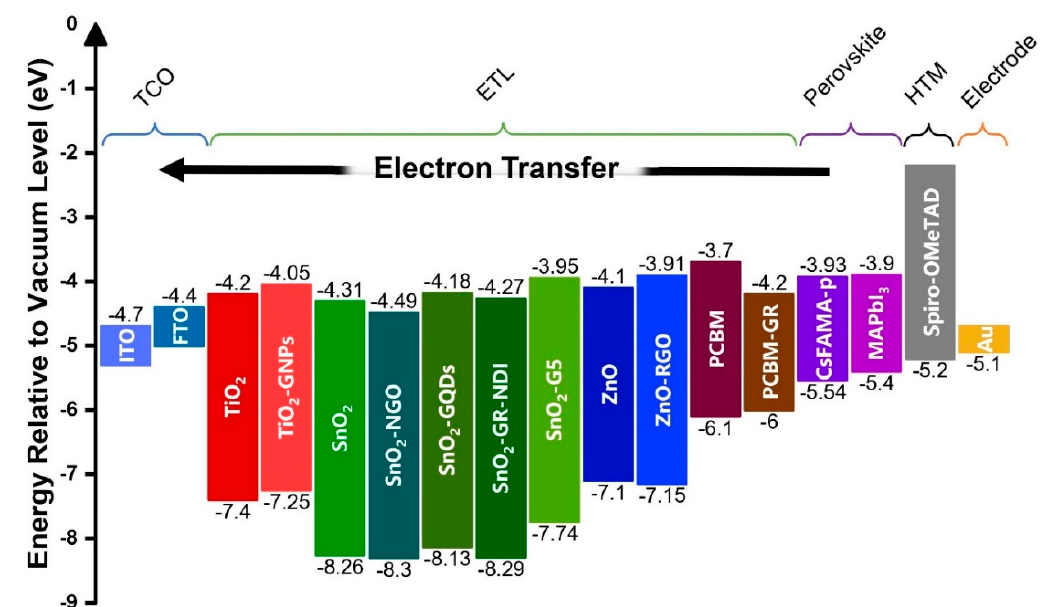
Figure 2. Reported CBM (conduction band minimum or lowest unoccupied molecular orbital, top) and VBM (valence band maximum or highest occupied molecular orbital, bottom) energy levels of TCO substrates, ETLs that have been modified using GBMs, HTM, and electrode [17,19,24,26,60,71,81]. ITO = indium tin oxide, FTO = fluorine-doped tin oxide, GNPs = graphene nanoplatelets, NGO = nitrogen-doped graphene oxide, NDI = napthalenetetracarboxylic diimide, G5 = 5 nm Ø GQDs, PCBM = fullerene derivative phenyl-C61-butyric acid methyl ester, NGR = N-doped graphene, CsFAMA-p = cesium containing mixed-cation mixed-halide perovskite, MaPbI 3 = methylammonium lead triiodide perovskite, Spiro-OMeTAD = 2,2 (cid:48) ,7,7 (cid:48) -tetrakis(N,N-di-p-methoxyphenyl-amine)9,9 (cid:48)